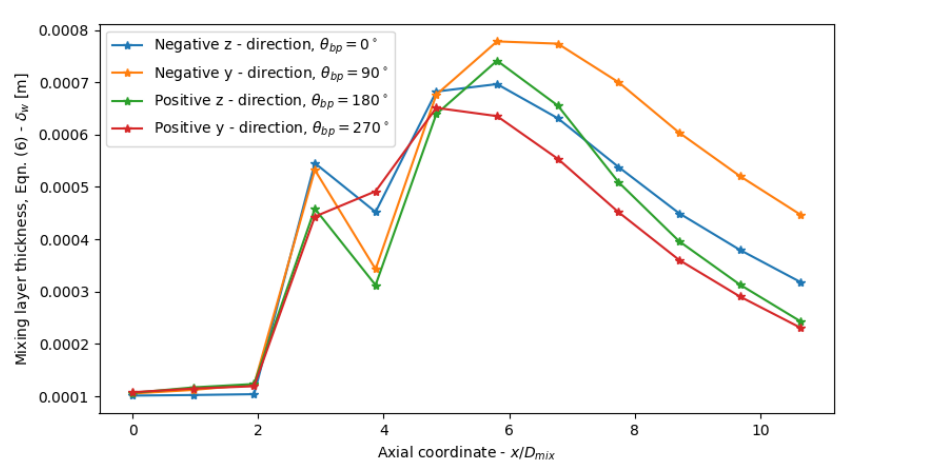
Figure 16. Plot of the mixing-layer thickness for an ejector with a bypass inlet calculated towards the wall in different radial directions plotted along the mixing-chamber center line.